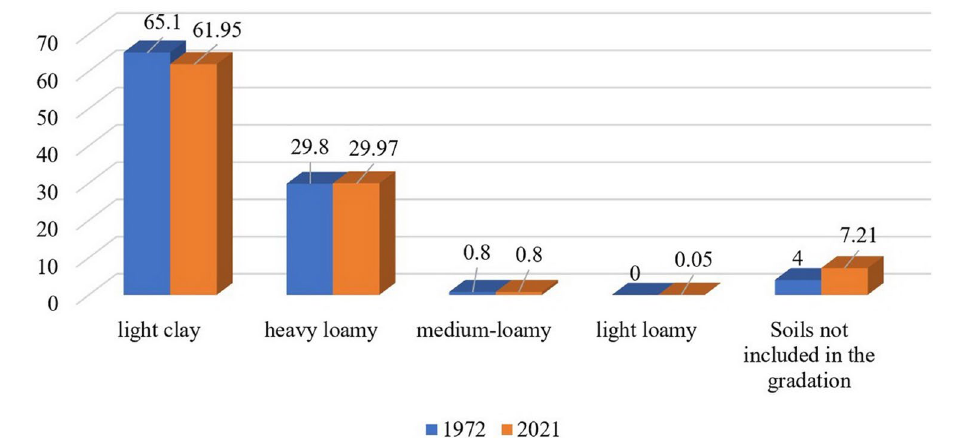
Figure 3. Distribution of Salavatskiy district soil areas by granulometric composition, %.